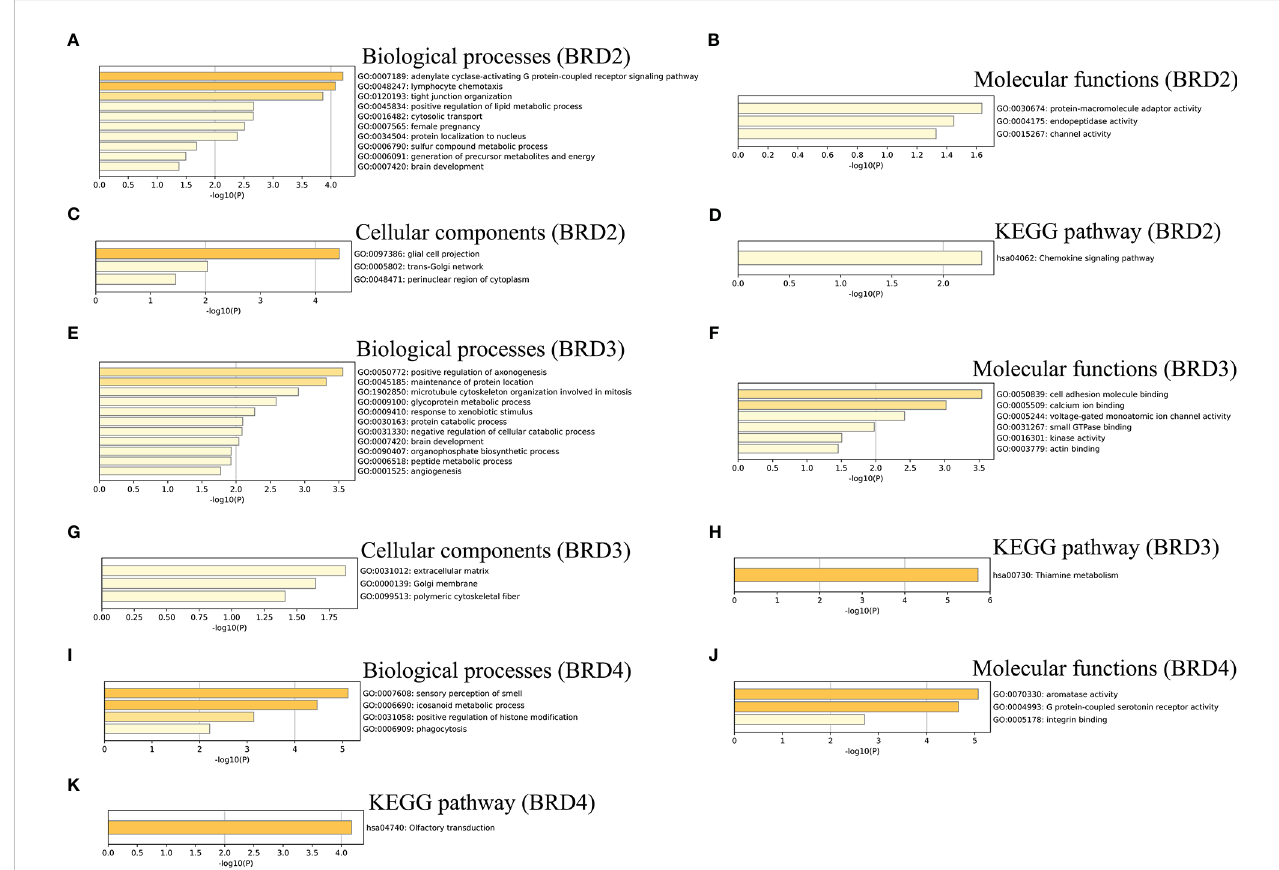
FIGURE 3 GO function and KEGG pathways enrichment analyses of BET family and their neighboring genes in ACC (metascape). (A) Biological processes of BRD2 and its neighboring genes; (B) Molecular functionsf BRD2 and its neighboring genes; (C) Cellular components of BRD2 and its neighboring genes; (D) KEGG pathway analysis of BRD2 and its neighboring genes; (E) Biological processes of BRD3 and its neighboring genes; (F) Molecular functionsf BRD3 and its neighboring genes; (G) Cellular components of BRD3 and its neighboring genes; (H) KEGG pathway analysis of BRD3 and its neighboring genes; (I) Biological processes of BRD4 and its neighboring genes; (J) Molecular functionsf BRD4 and its neighboring genes; (K) KEGG pathway analysis of BRD4 and its neighboring